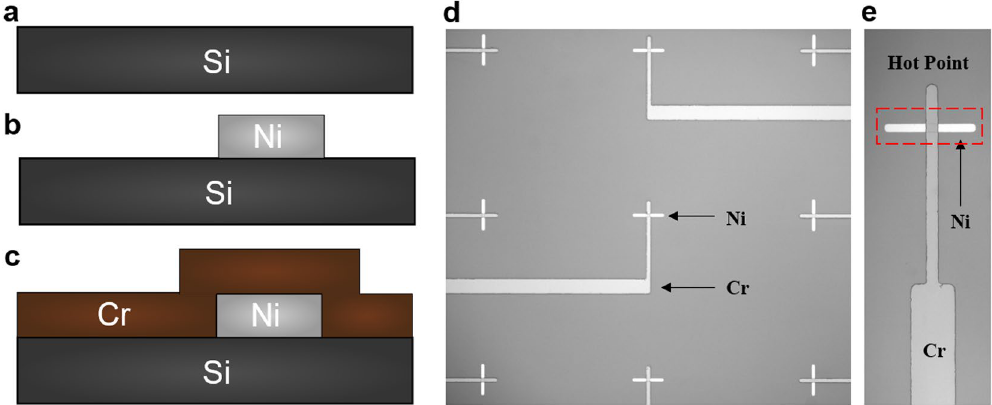
Figure 3. Fabrication of chrome-silicon thermocouples on a silicon wafer. ( a ) Start with a blank silicon wafer (dark grey in the drawing). ( b ) Deposit thin film of nickel (100 nm, silver in the drawing) on the wafer followed by liftoff patterning. ( c ) Deposit and pattern chromium (100 nm, brown in the drawing) on the wafer using liftoff. ( d ) Optical microscope image of an a fabricated 3 × 3 array of thermocouples with nickel patches of different shapes at the hot points. ( e ) A close-up optical microscope image of a hot point: the lighter, horizontal bar is made of nickel.